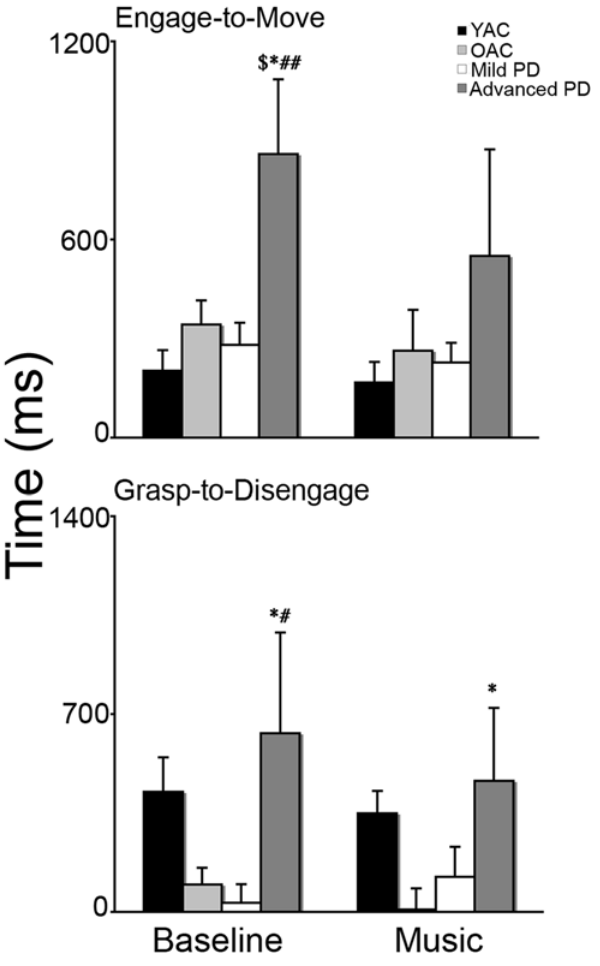
Figure 10. Time to complete engage to move and grasp to disengage (mean and standard error) for the four groups at baseline (left) and with preferred musical pieces (right). $ = advanced PD . YAC at p , 0.001; * = advanced PD . OAC at p , 0.001; # =advanced PD . mild PD at p , 0.05.